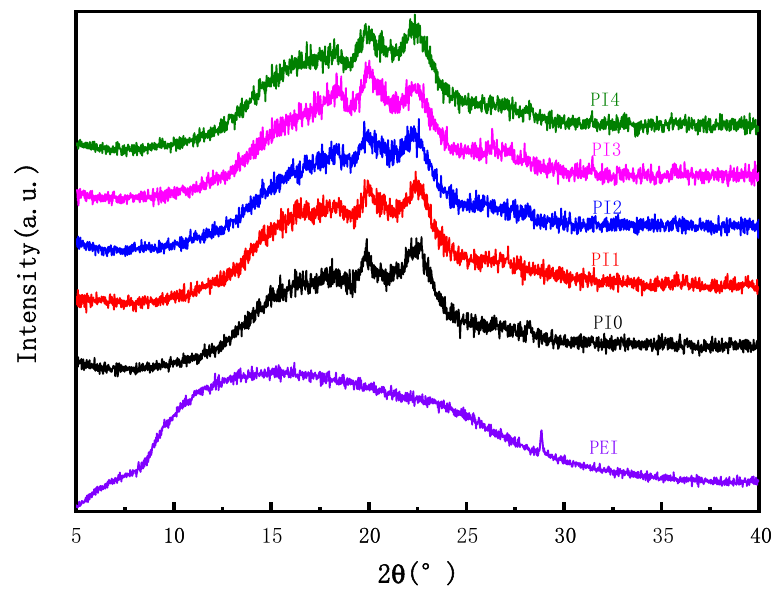
Figure 2. XRD patterns of blended membranes with different PEI contents.